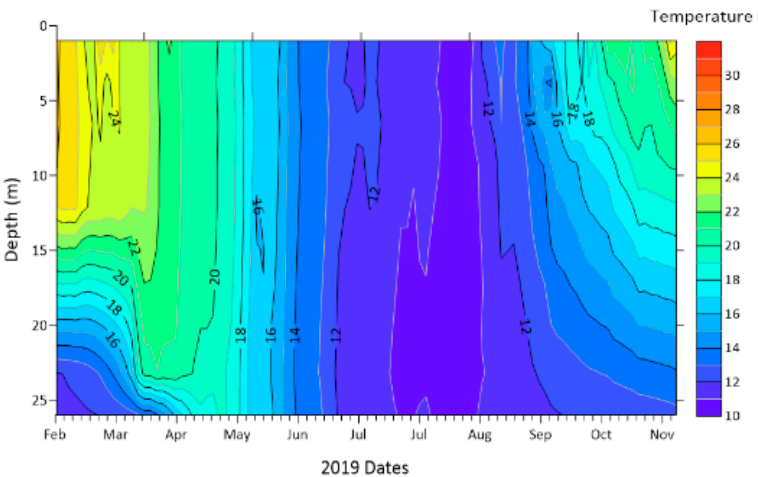
Figure 3. Temperatures in Hunter Lake 1 (February–November 2019) as measured by in situ continuous monitoring chains.